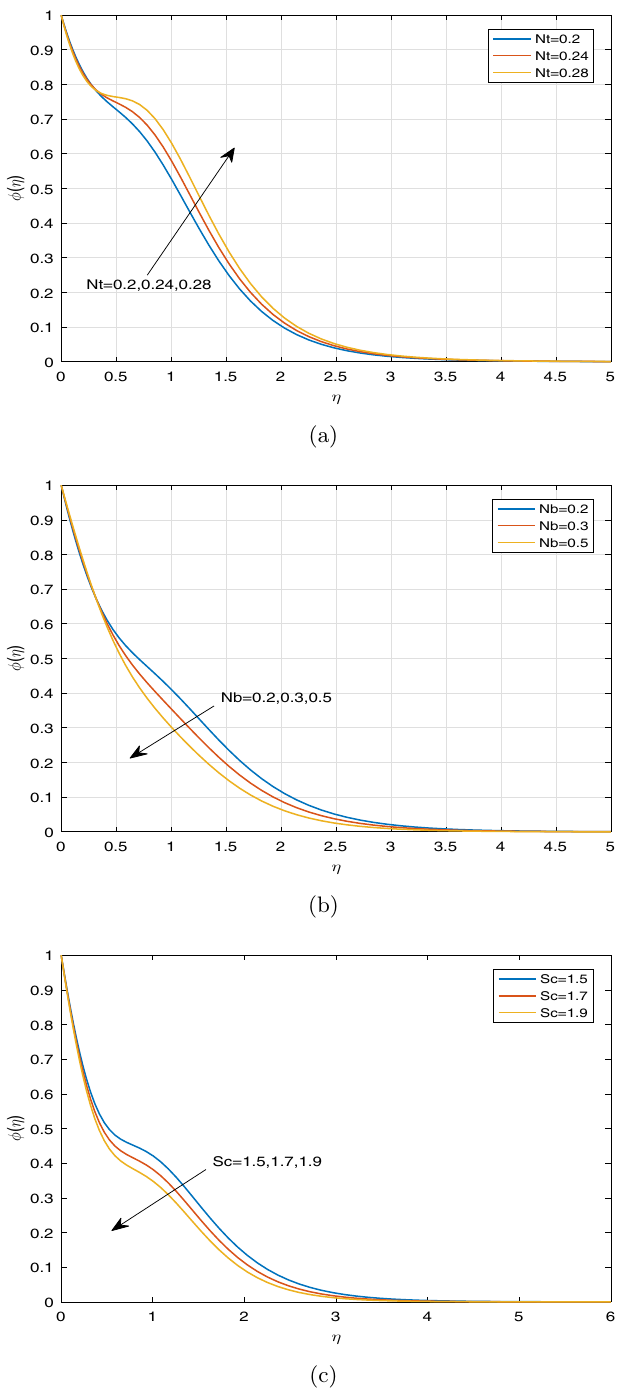
Figure 10. Concentration profiles against the disperate values of pertinent parameters ( a ) Nt, ( b ) Nb, ( c )